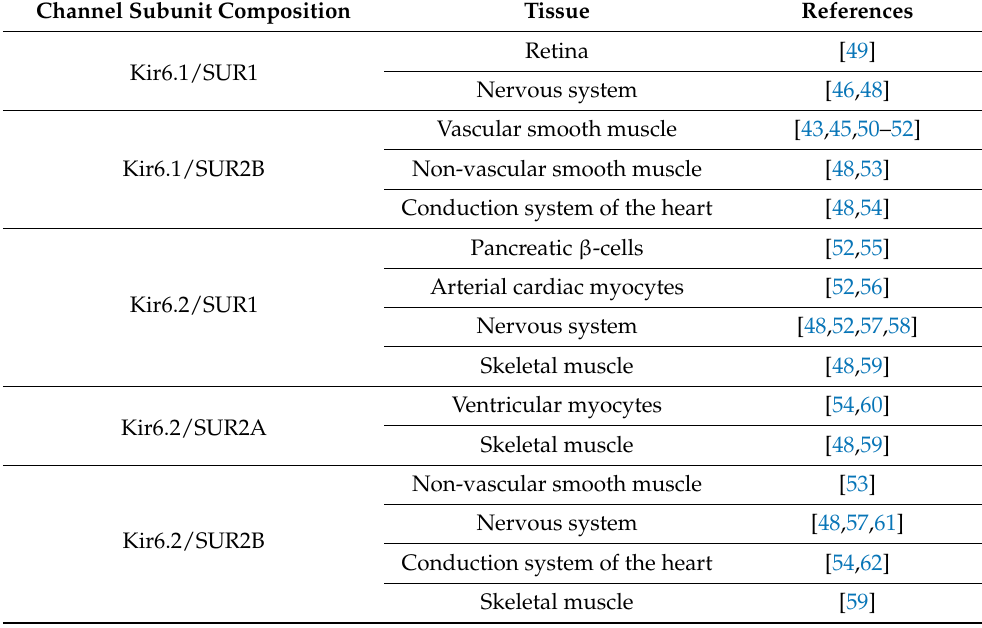
Table 1. Subunits composition and tissue expression of K ATP channels. For a more detailed overview of subunit composition, tissue distribution and physiological function, please see